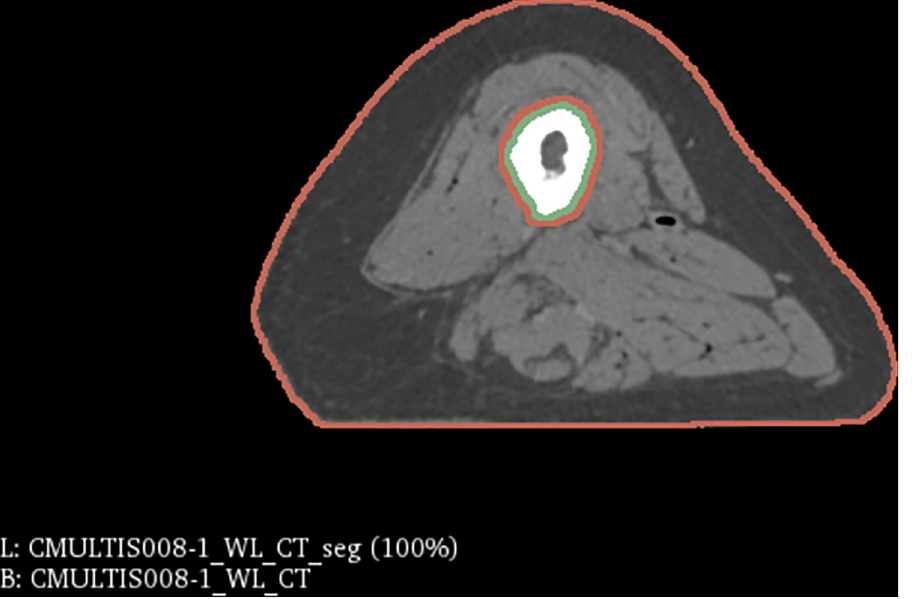
Fig 1. A computed tomography scan image of the female upper leg specimen with segmentation regions shown in 3D slicer. The bone is contained in the green region and the flesh component is contained within the red region.